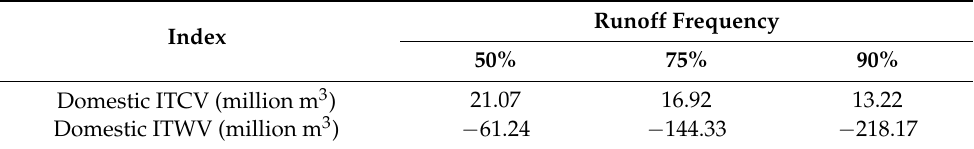
Table 13. The domestic ITWV and ITCV in Changsha city in 2030 under different runoff frequencies. Index